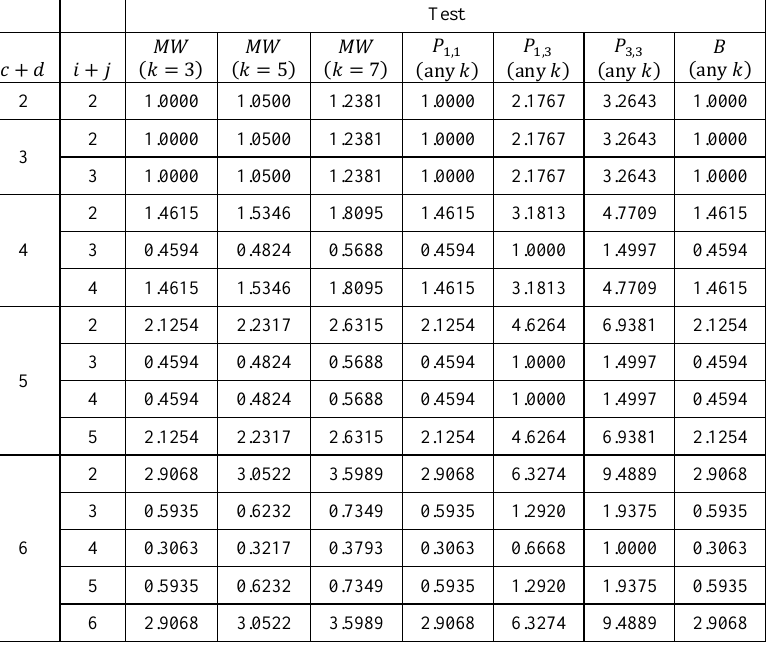
Table 1. AREs of 𝑇 for U-quadratic distribution w.r.t. different 𝑐,𝑑;𝑖,𝑗